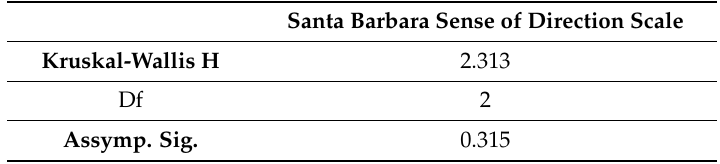
Table 5. Kruskal–Wallis H Test results regarding pre-study participants’ spatial abilities. Santa Barbara Sense of Direction Scale Kruskal-Wallis